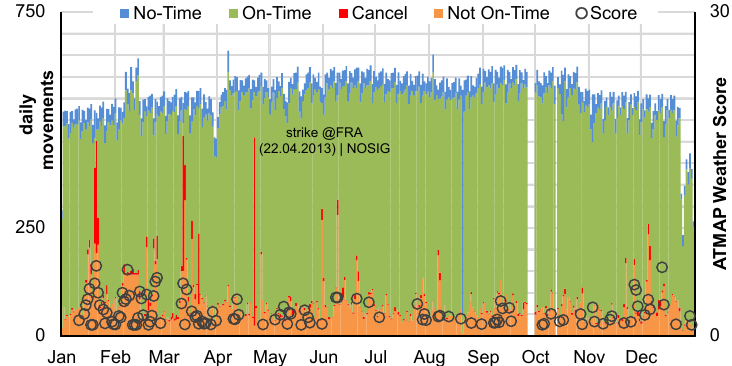
Figure 3. Airport performance data and ATM Airport Performance (ATMAP) weather